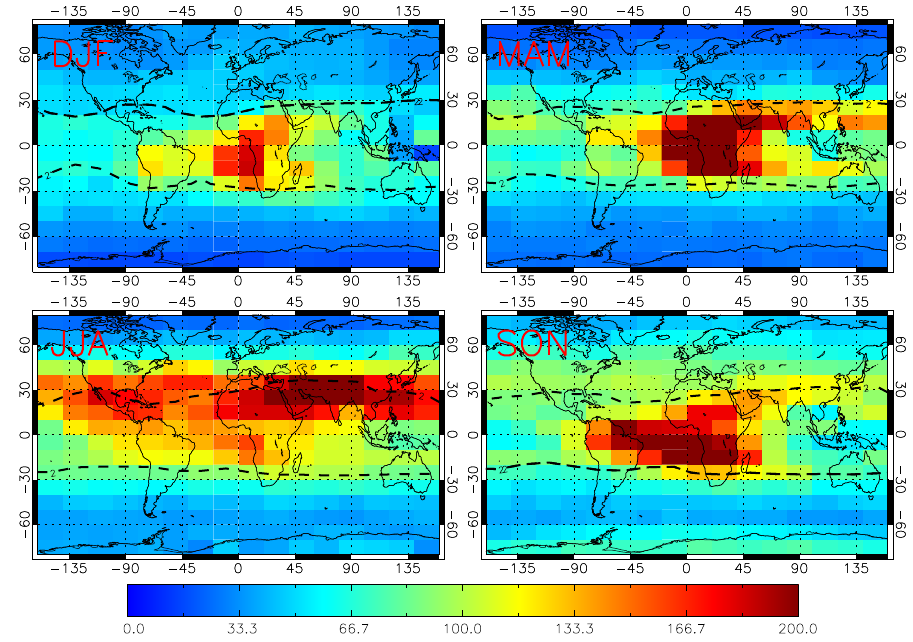
Figure 2. MIPAS PAN (pptv) from the IMK retrieval at 150hPa for 2007–2008 in December–January–February (DJF), March–April– May (MAM), June–July–August (JJA), and September–October–November (SON). The black dashed lines show the dynamical tropopause (defined as ± 2PVU) based on ERA-Interim